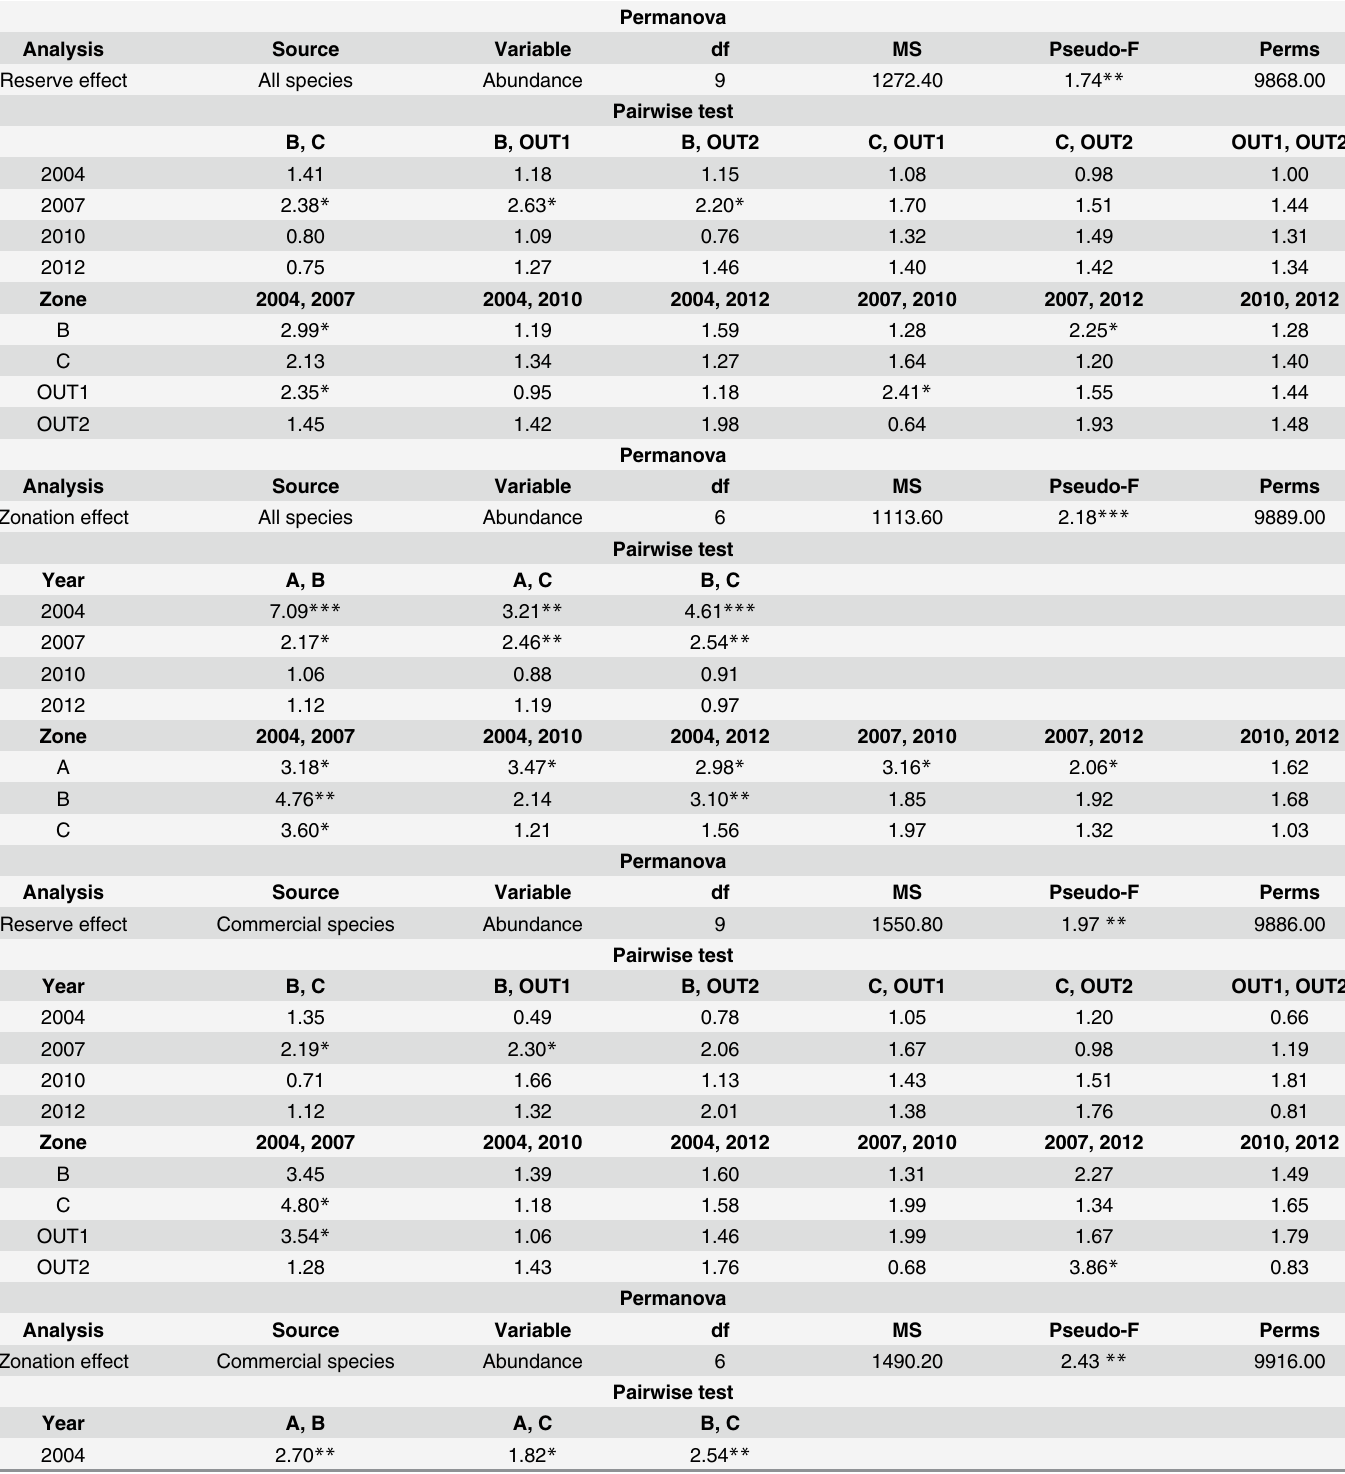
Table 4. Results of multivariate Permanova analyses on square root transformed data for “ Year x Protection ” factor. Pairwise tests are reported in the event of statistical